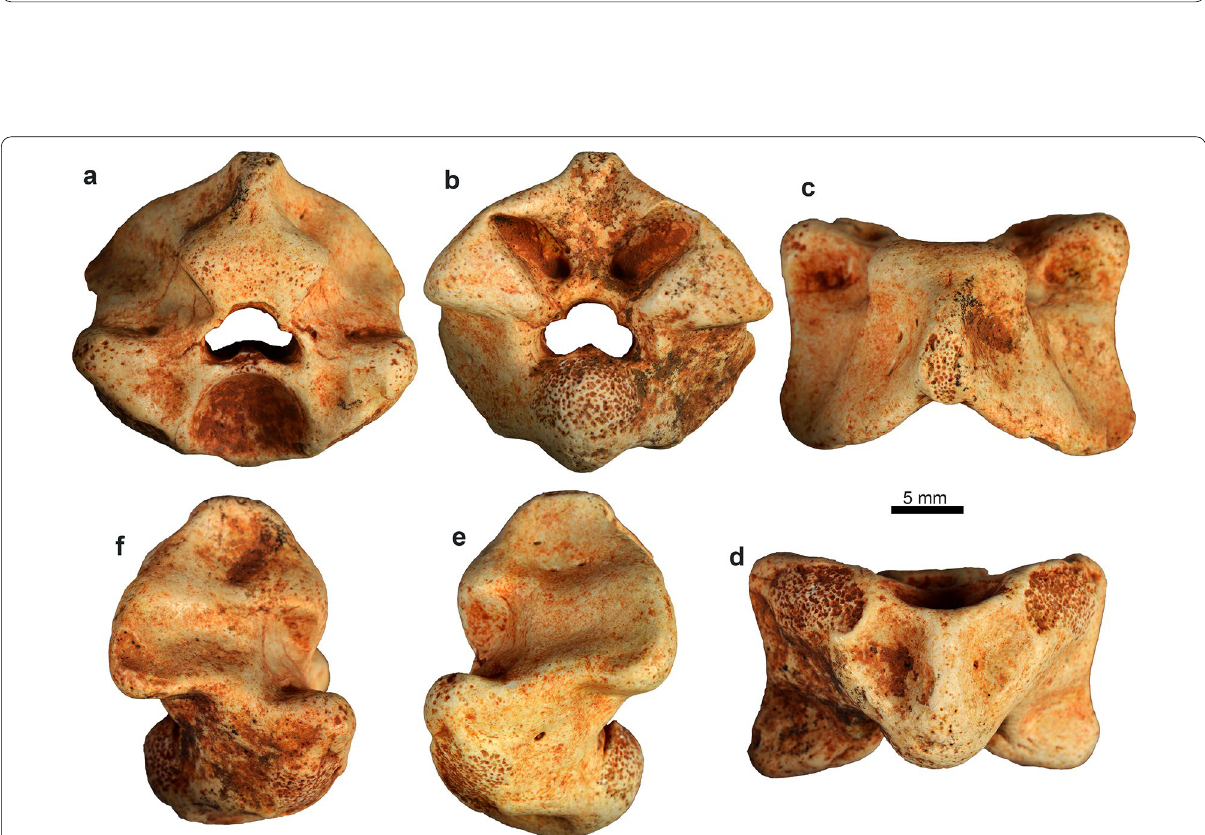
Fig. 14 Palaeopython cadurcensis from an imprecisely known locality in the Phosphorites du Quercy: posterior trunk vertebra (NHMW 2019/0032/0002) in anterior ( a ), posterior ( b ), dorsal ( c ), ventral ( d ), left lateral ( e ), and right lateral ( f ) views. Note that the vertebra is considerably